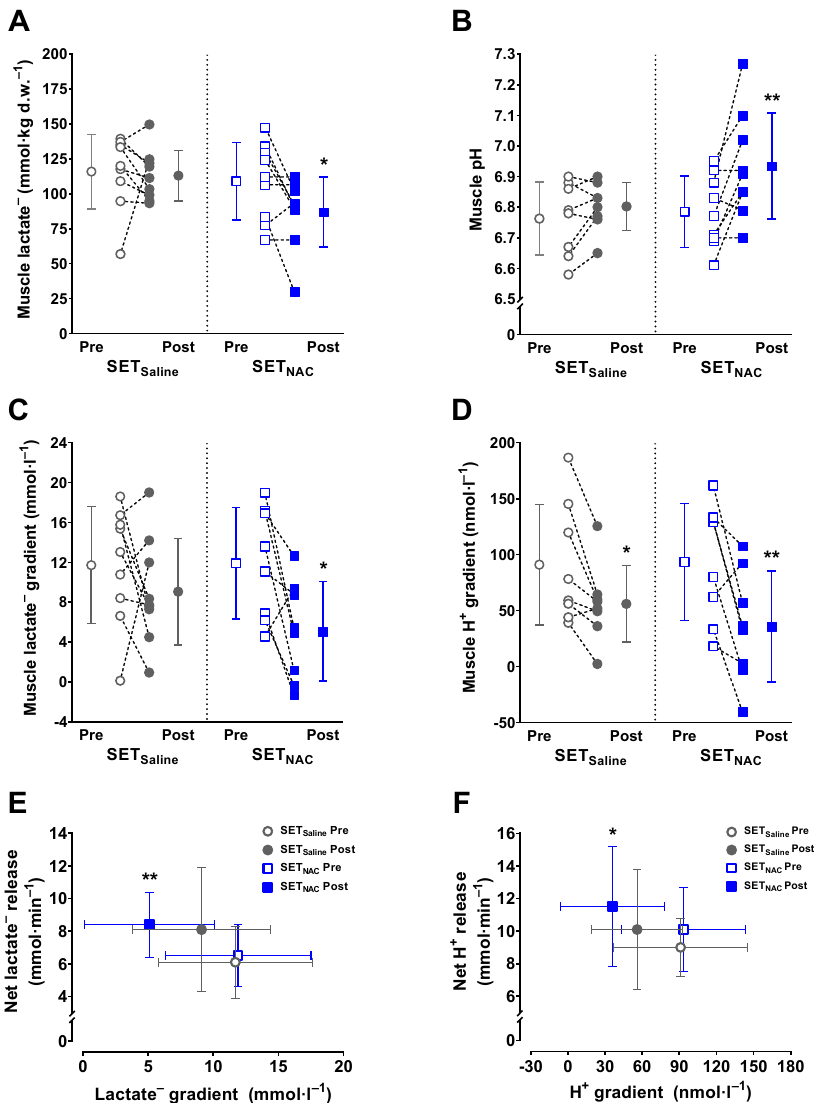
Figure 9. Effect of speed endurance training (SET) on muscle lactate - and pH at exhaustion without and with N -acetylcysteine infusion. Muscle [lactate - ] (( A ), SET Saline , n = 9; SET NAC , n = 8), muscle pH (( B ), SET Saline , n = 8; SET NAC , n = 8), muscle [lactate - ] gradient (( C ), SET Saline , n = 9; SET NAC , n = 8), muscle [H + ] gradient (( D ), SET Saline , n = 8; SET NAC , n = 8) and the relationship between muscle gradients and net release (( E , F ) , SET Saline , n = 9; SET NAC , n = 8) immediately after knee-extensor exercise to exhaustion without (SET Saline ) and with N -acetylcysteine (SET NAC ) infusion before (pre) and after (post) SET. ** Post different from pre ( p < 0.01). * Post different from pre ( p < 0.05). Data are presented as mean ± SD with individual changes ( A – D ) or as mean ± SD ( E , F ).